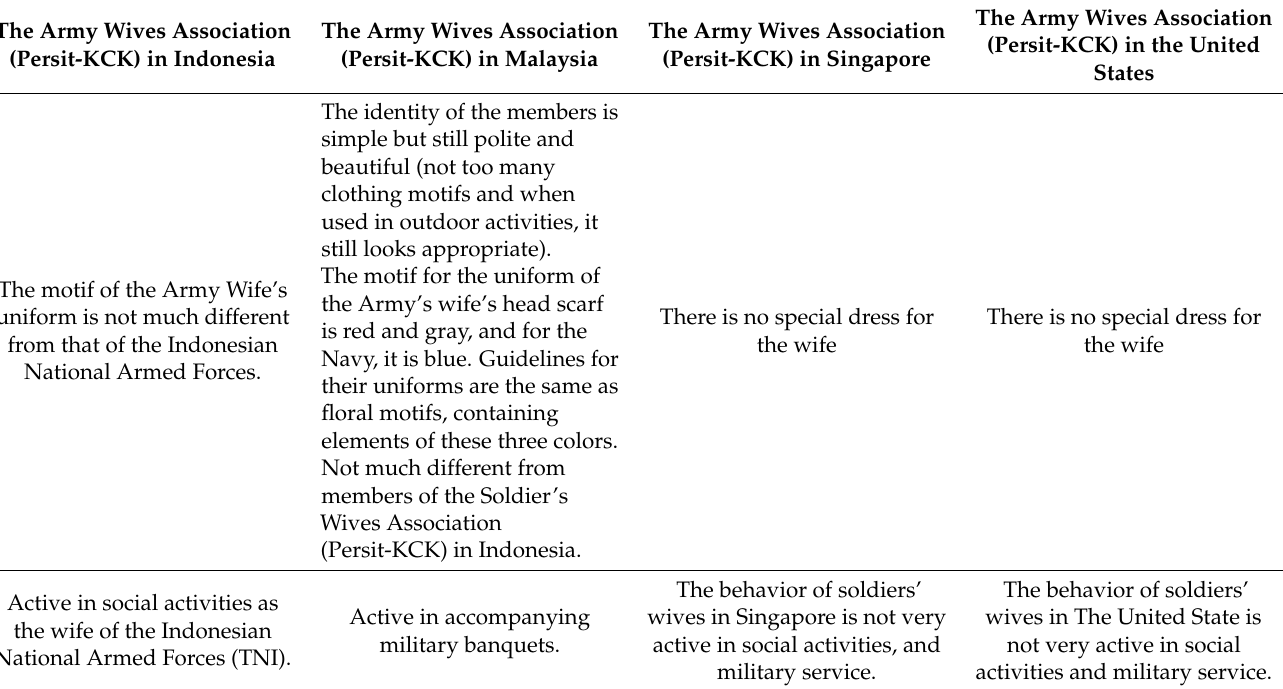
Table 1. Organizational symbols and member